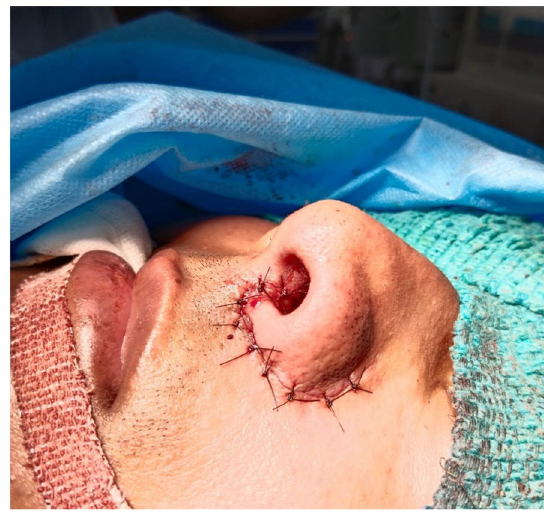
Fig. 4 Post-excision sutured nasal cavity